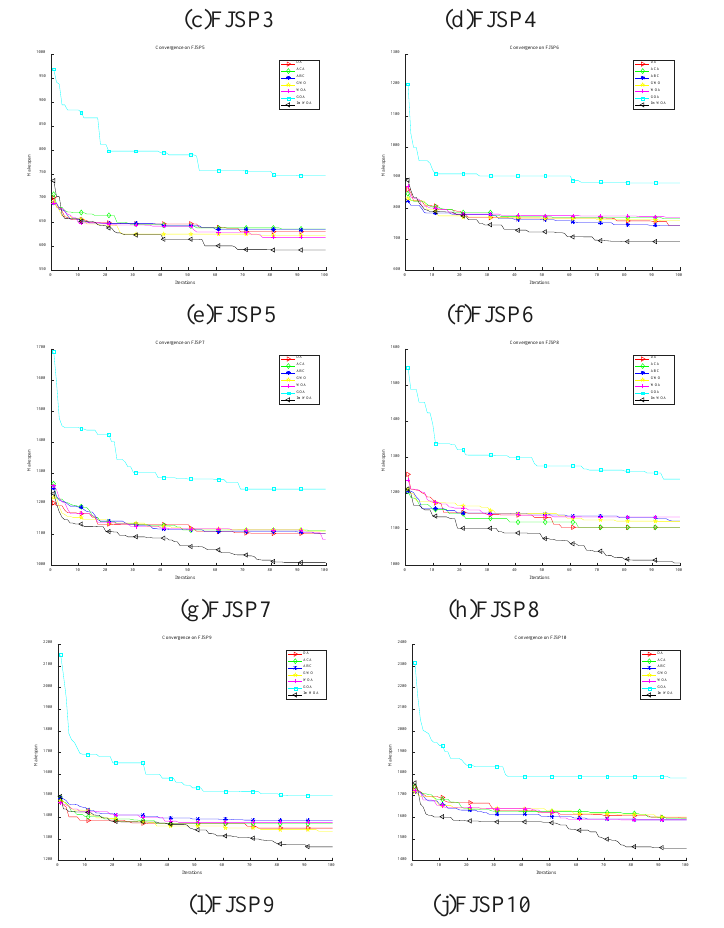
Fig. 2. The convergence cruve of algorithm.